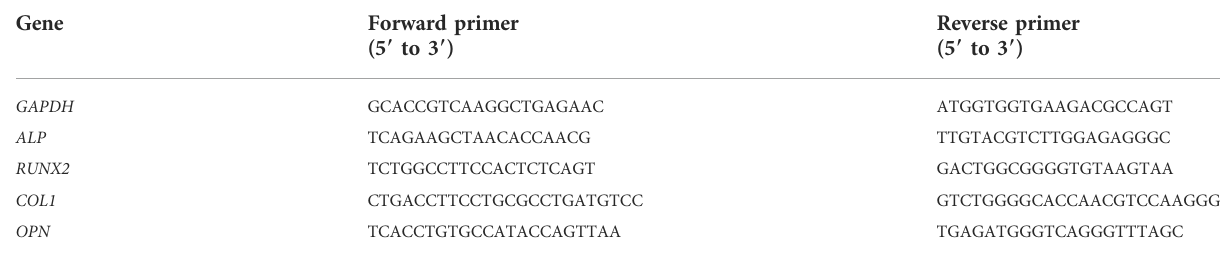
TABLE 1 List of primer sequences used in Real-time PCR.